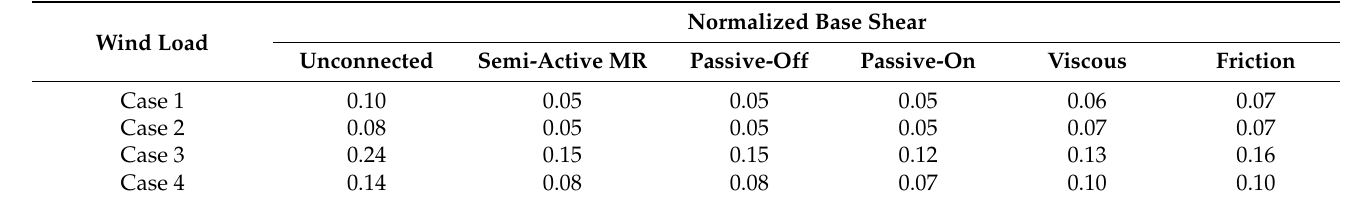
Table 12. Comparison of peak normalized base shear of the coupled stiff building under different control strategies when dampers are arranged in Configuration 1.